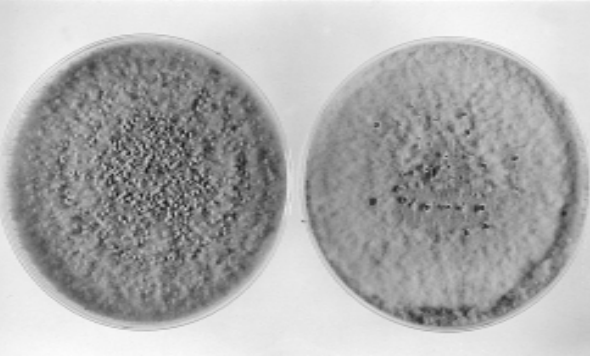
Fig. 4. Cultures of Fusicoccum luteum (left) and F. aes- culi (right) on oatmeal